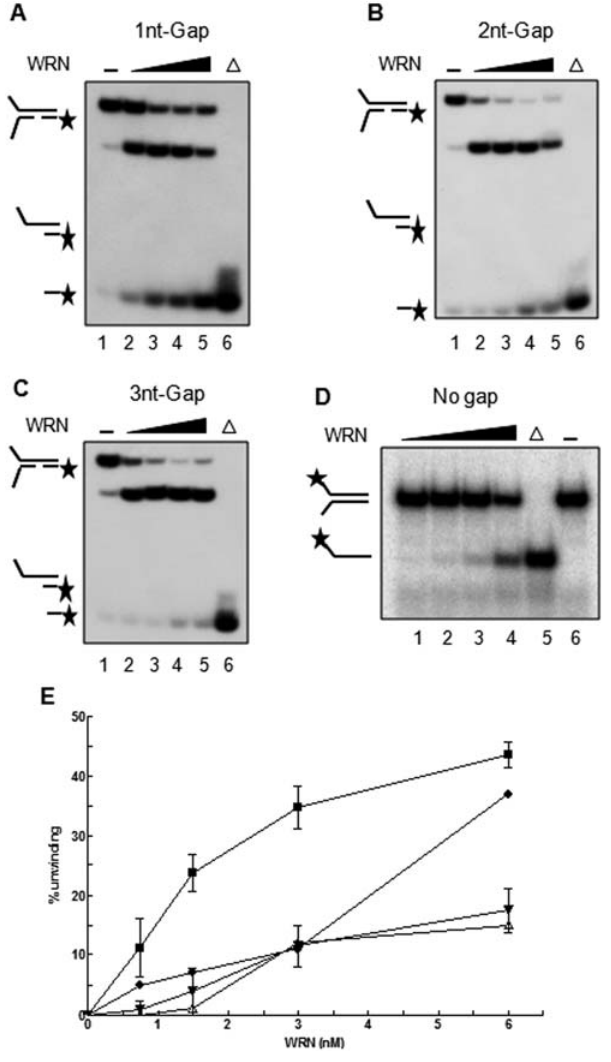
Figure 2. Radiometric DNA helicase assay using gap substrates and WRN. Each assay was performed using 1.5 nM of each substrate and a range of WRN concentration from 0.75 to 6 nM. A cold trap oligomer complementary to the unlabeled, unwound oligomer (100- fold) was added at the end of the enzymatic reaction. (A) A representative gel picture of the assay using 1-nt gap. The arrows indicate the migration pattern of the unwound product (radiolabeled ss oligomer). (B) A representative gel picture of the assay using 2-nt gap substrate. (C) A representative gel picture of the assay using 3-nt gap substrate. (D) A representative gel picture of the assay using DNA substrate without a gap. (E) Quantitations of at least three or two independent experiments shown in A and B. The graph is plotted as the percentage of unwound product on the Y-axis and the concentration of WRN on the X-axis. The mean values of three different experiments were plotted with standard deviation indicated by error bars (1-nt gap substrate and 2-nt gap substrate). Filled-circles indicate DNA substrate without a gap. Likewise, filled-squares indicate 1-nt gap substrate, filled- inverse triangles indicate 2-nt gap substrate and open triangles, 3-nt gap substrate. Asterisk indicates a 5 9 - 32 P labeled strand. D indicates boiled substrate.